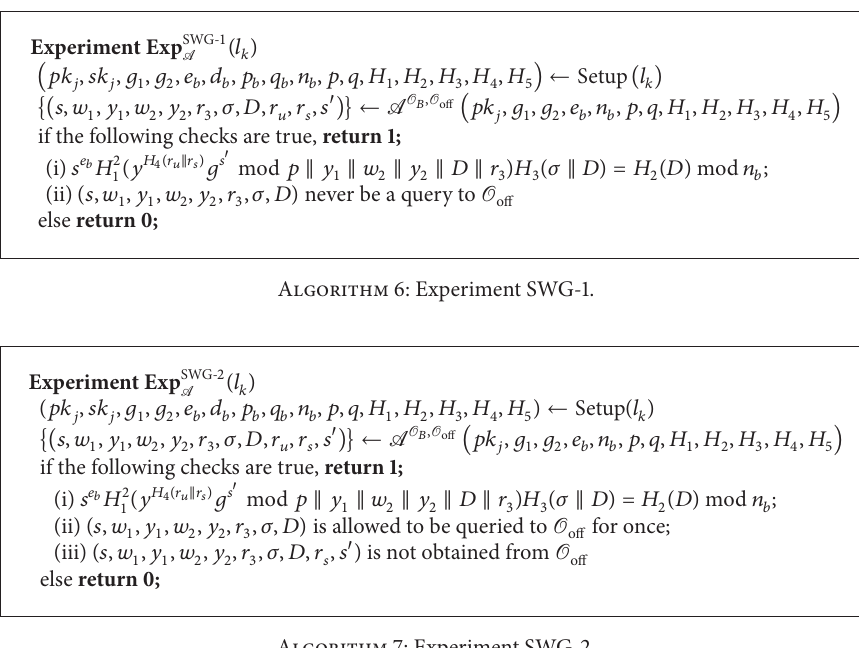
Algorithm 7: Experiment